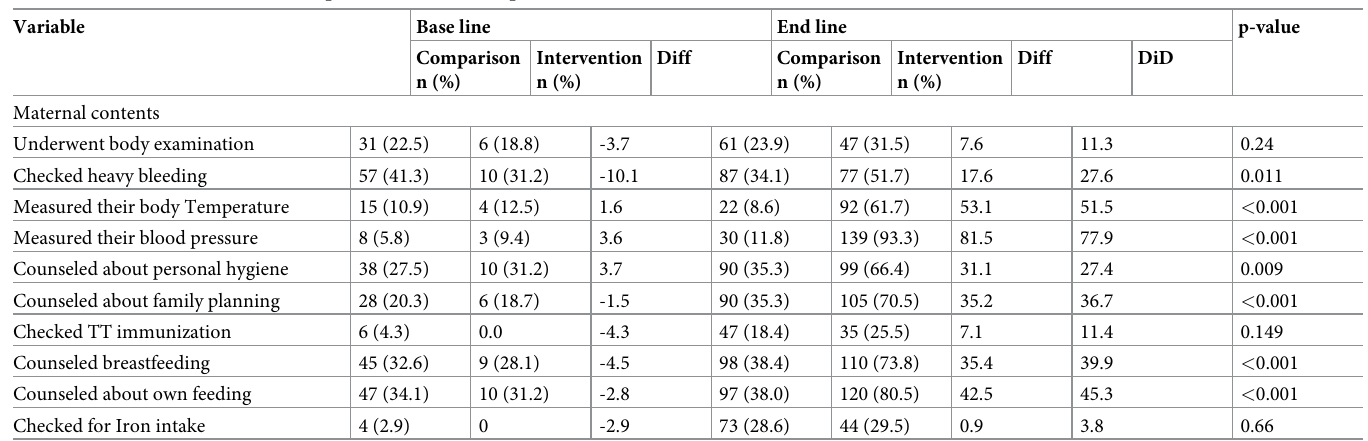
Table 4. Effect of the intervention on provision of maternal postnatal contents at home.